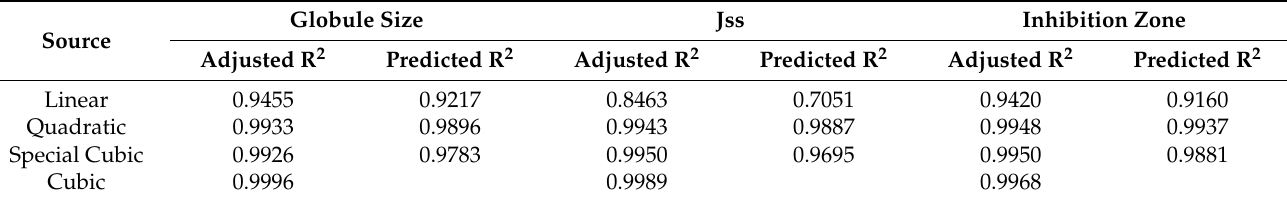
Table 6. Fit Summary for